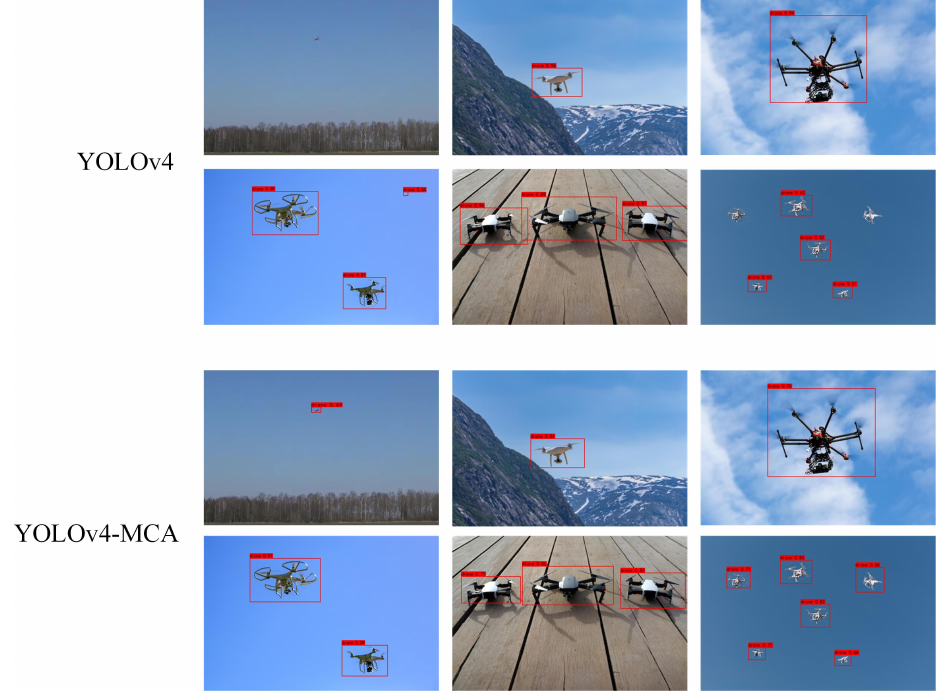
Figure 9. The comparison results of YOLOv4 and